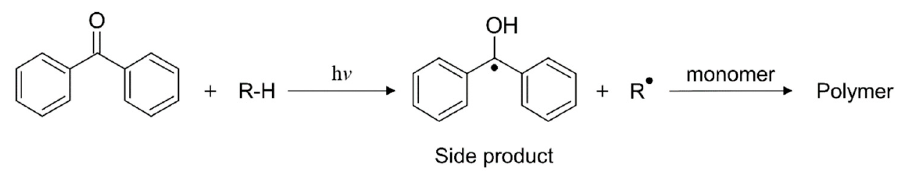
Table 4. List of radical photoinitiators used in vat photopolymerization 3D printing.